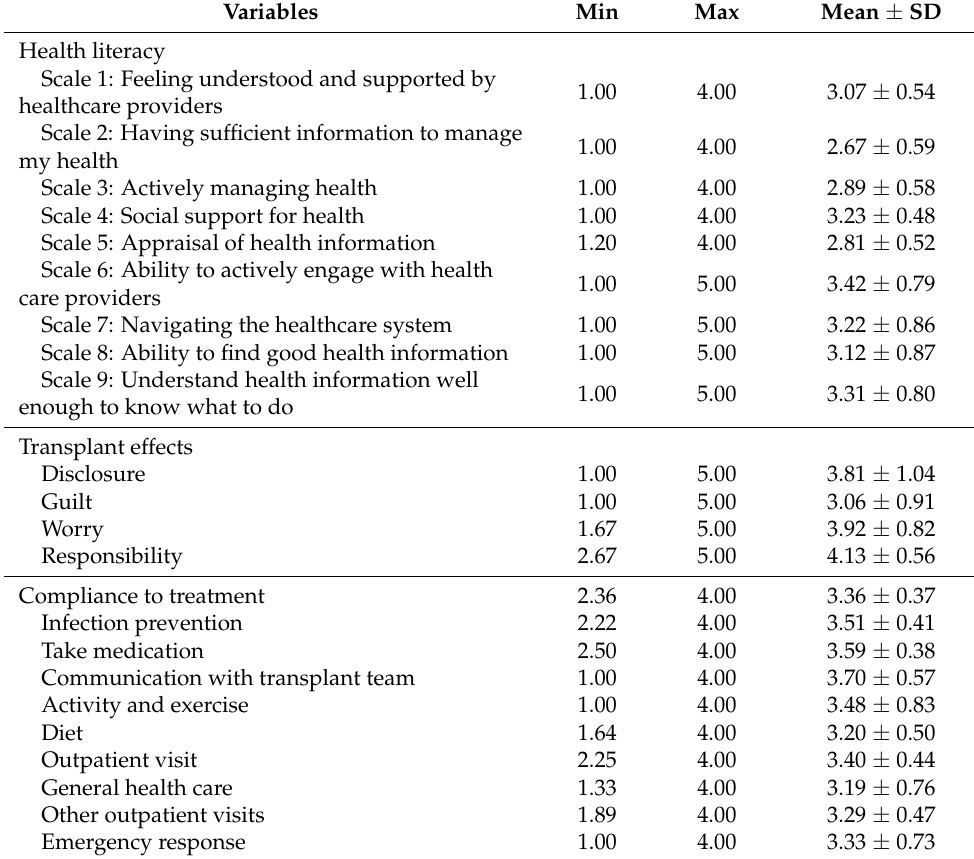
Table 3. Health literacy, transplant effects, and compliance to treatment ( n = 130).